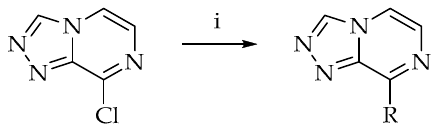
Scheme 1. Synthesis of 1 – 6 . Reagents and conditions : (i) amino derivative (2 equiv.), PEG400, 120 °C, 5 min, 70–95%. Table 1. Results of the S N Ar on 4-chloro-2-methylimidazo[1,5- a ]pyrimidine-8-carbonitrile with various amines.